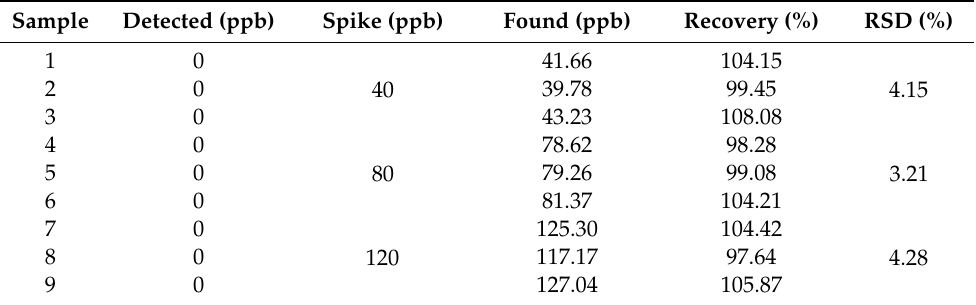
Table 1. Recovery studies in actual water samples.